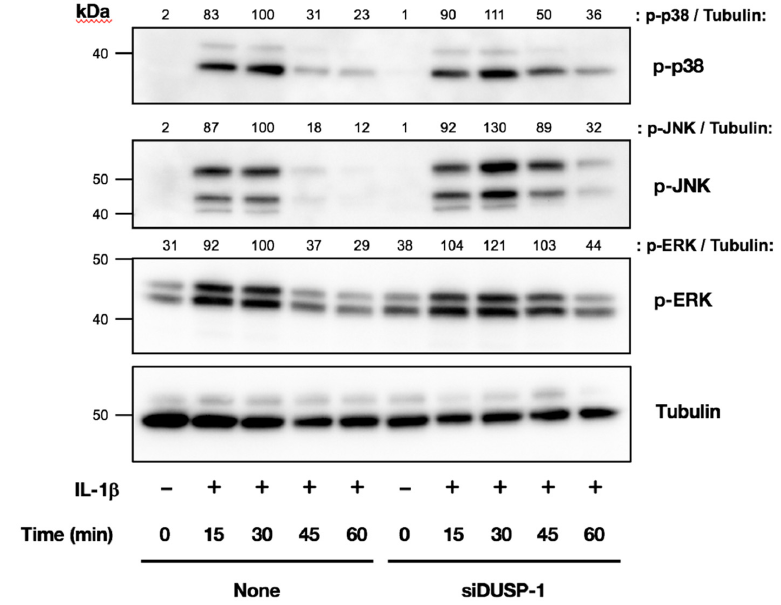
Figure 5. Effects of DUSP-1 knockdown on IL-1 β -induced MAPK phosphorylation in human IVD cells. DUSP-1 knockdown and untransfected cells were serum starved and then stimulated with IL- 1 β (10 ng/mL) for 15, 30, 45, and 60 min. The phosphorylation of MAPKs was analyzed by Western blotting. IL-1 β -induced MAPK phosphorylation was increased and prolonged in DUSP-1 knockdown cells compared with untransfected cells. Results were reproducible among three individuals and representative blots are shown.